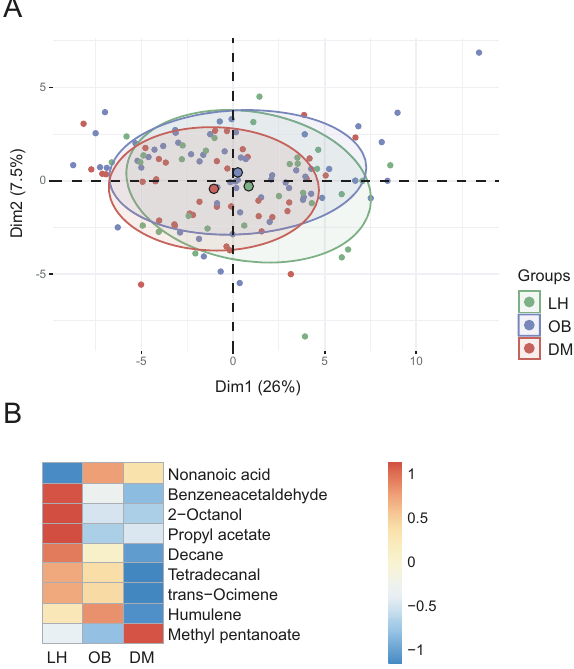
Fig. 2 Fecal metabolome composition. A 2D PCA scores plot on VOCs abundances after clr transformation. Only VOCs meeting condition AUC x,p ≥ 0.1% AUC total,p are shown. The explained variance of each component is included in the axis labels. The large points represent the centroids of each group. B Abundances of signi fi cant metabolites. Proportional data were used. Each cell then represents the median in each group for the corresponding metabolite. Rows were